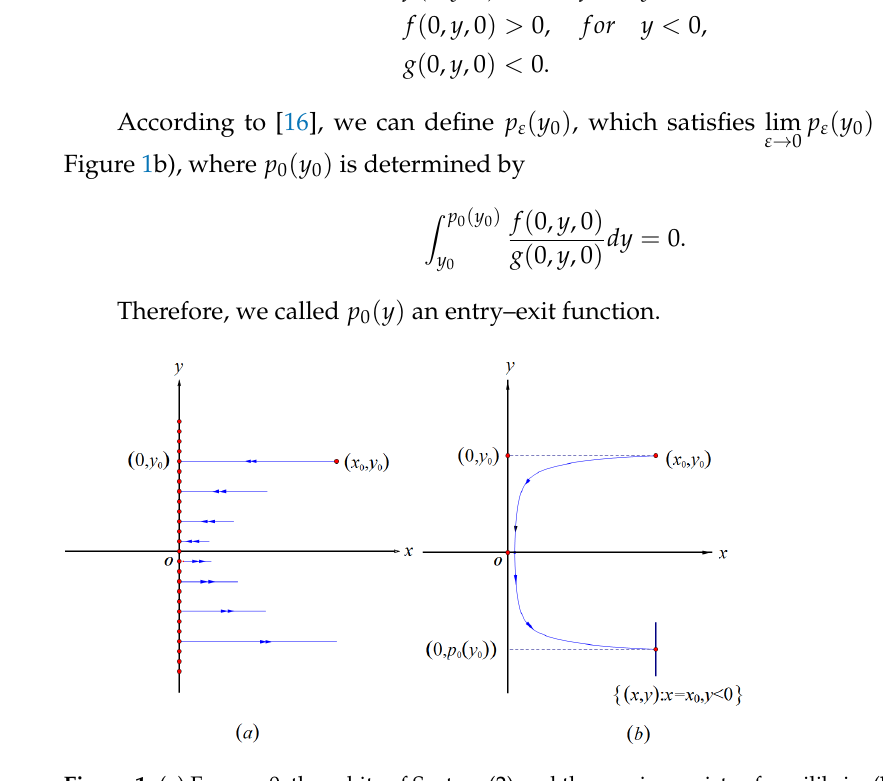
Figure 1. ( a ) For ε = 0, the orbits of System (2) and the y -axis consists of equilibria. ( b ) For 0 < ε (cid:28) 1, a symbolic orbit of System (2), which starts at ( x 0 , y 0 ) and ends at { x = x 0 , y 0 < 0 }